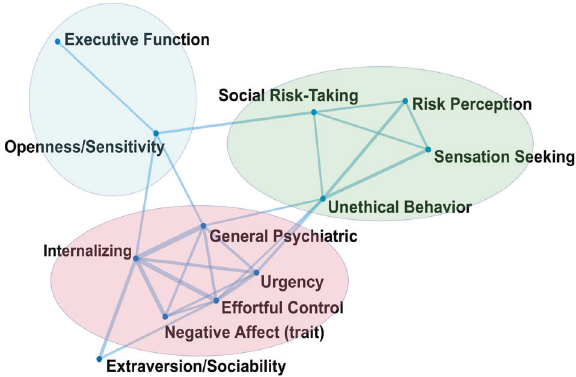
Fig. 1 Spring-embedded network of 12 latent factors from EFA. In a spring-embedded network, nodes that are more strongly correlated are plotted closer together in two-dimensional space. Each node represents an EFA factor. Three functional domains emerged across all participants based on the underlying factor correlations: (1) an Approach-Related functional domain (green), (2) an Executive Function functional domain (blue), and (3) a Negative Emotionality functional domain